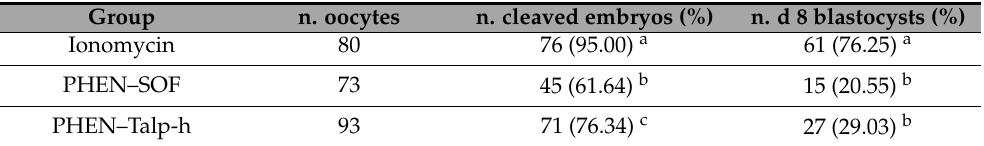
Table 1. In vitro preimplantation development of parthenogenetic bovine embryos using the Zn chelator PHEN at 0.5 mM for 1 h in two different media. Group n. oocytes